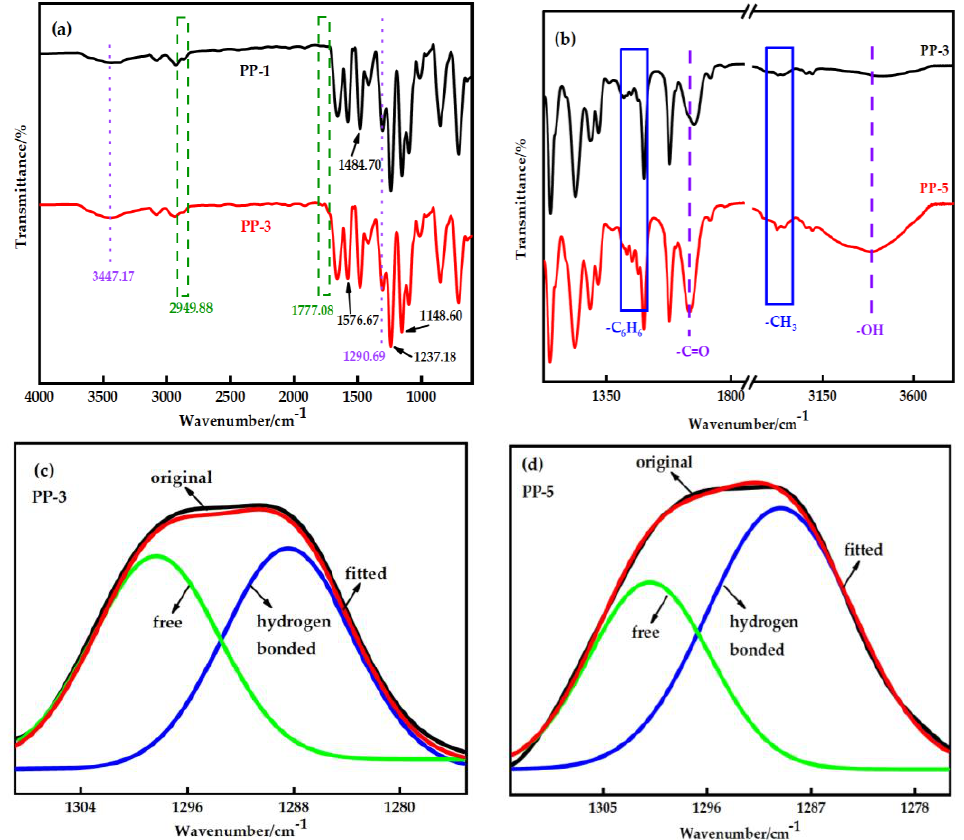
Figure 4. ( a ) Fourier infrared spectra of the PP-1 and PP-3 membranes; ( b ) The characteristic peaks of methyl and benzene rings are in PP-3 and PP-5 membranes; ( c ) Curve fitting results in the sulfone group stretching region of the PP-3 membrane; ( d ) Curve fitting results in the sulfone group stretching region of the PP-5 membrane.